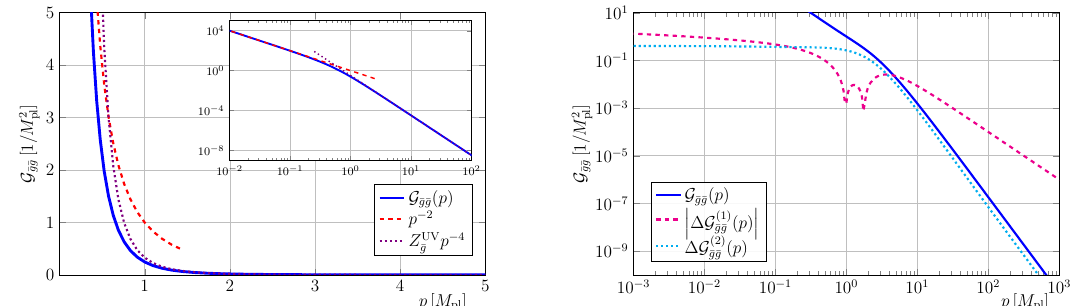
Figure 6: Momentum dependence of the Euclidean background graviton propagator ( p ) . (left) Momentum dependence of the Euclidean background graviton propa- G ¯ g ¯ g gator (blue, solid) with its IR and UV asymptotics. The UV asymptotic (violet, dotted) ≈ 18.5, see (25). The IR asymptotic (red, dashed) is simply is given by p − 4 with Z UV ¯ g the classical dispersion 1 / p 2 . (right) Subleading contributions at small momenta in ( 1 ) comparison to the full propagator (blue, solid). ∆ (magenta, dashed) carries ¯ g ¯ g G ( 2 ) a subleading log-like contribution, while ∆ (cyan, dotted) carries a constant ¯ g ¯ g G contribution for small